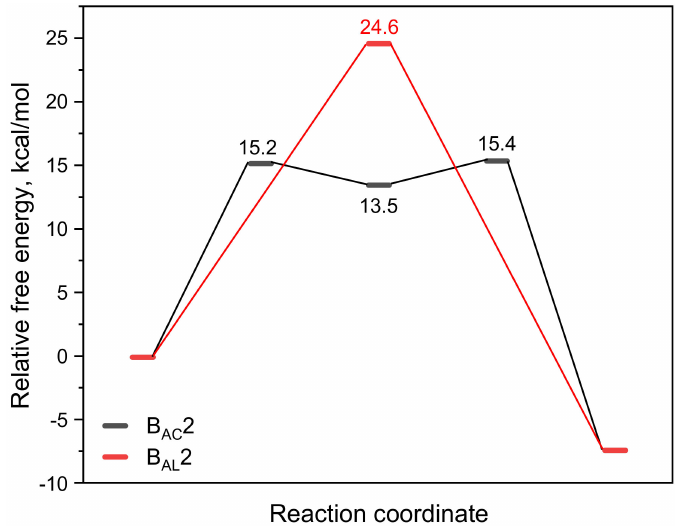
Figure 4. Variation in the relative free energy ( ∆ G ) along the B AC 2 and B AL 2 reaction paths for the alkaline hydrolysis of